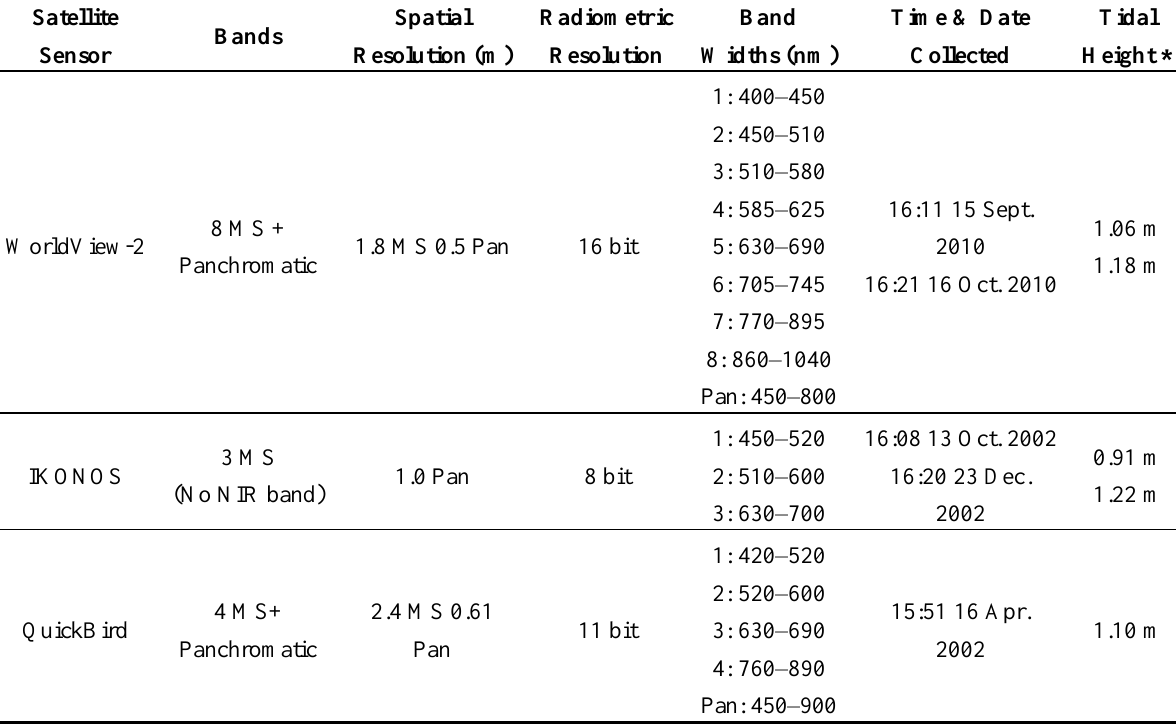
Table 1. Specifications of each satellite sensor used and corresponding tidal